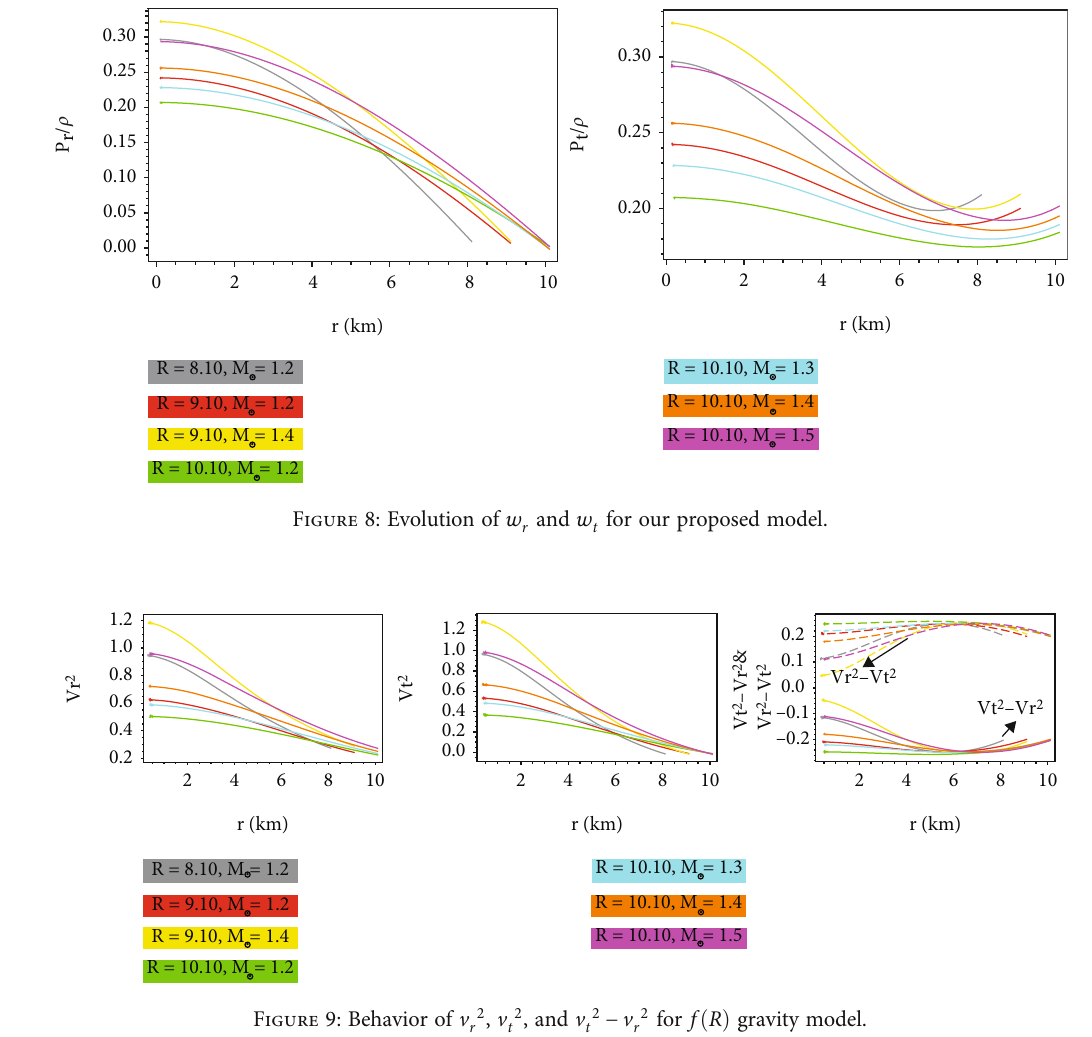
Figure 9: Behavior of v